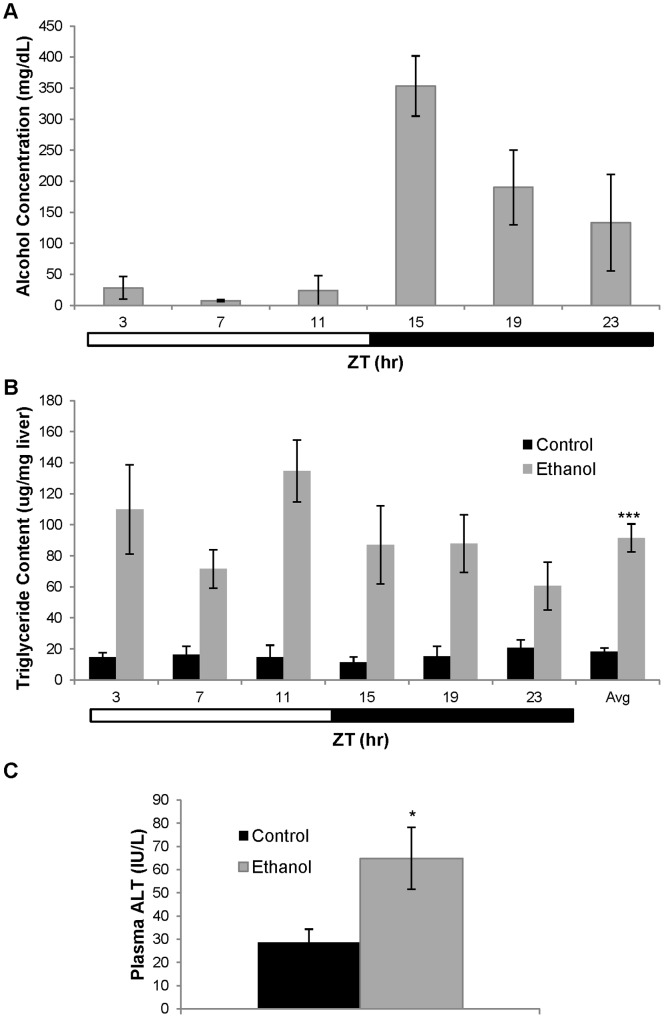
Biochemical measurements in C57BL/6J mice.A) Blood alcohol concentration (BAC) in ethanol-fed C57BL/6J mice. One-way ANOVA analysis revealed significant changes in BAC over a 24 hour period (p<0.001). Data are presented as mean ± SEM for 3–5 ethanol-fed mice at each ZT time. B) Triglyceride content in livers from control (▪) or ethanol-fed (grey square) mice. Two-way ANOVA was performed to determine significant effects of time and/or treatment on triglyceride content. There was no main effect of time (ZT) on liver triglyceride levels (F(5,52) = 1.595, p = 0.178) and no significant interaction between ZT time and diet (F(5,52) = 1.995, p = 0.095). However, there was a significant main effect of diet (F(1,52) = 91.125, p<0.0001). Significant differences in mean triglyceride content across all ZT times were determined using a t-test. Data are presented as mean±SEM for 4–6 control and ethanol-fed mice at each time point with the mean triglyceride content across all times shown in the last set of bars (n = 28 control and 28 ethanol-fed mice). ***p<0.0001, compared to control. C) Plasma ALT levels in control (▪) and ethanol-fed (grey square) mice. ALT levels were significantly increased in ethanol-fed mice as determined by Mann-Whitney Rank Sum Test (*p = 0.019). Data are presented as mean ± SEM for 21 control mice and 16 ethanol-fed mice.